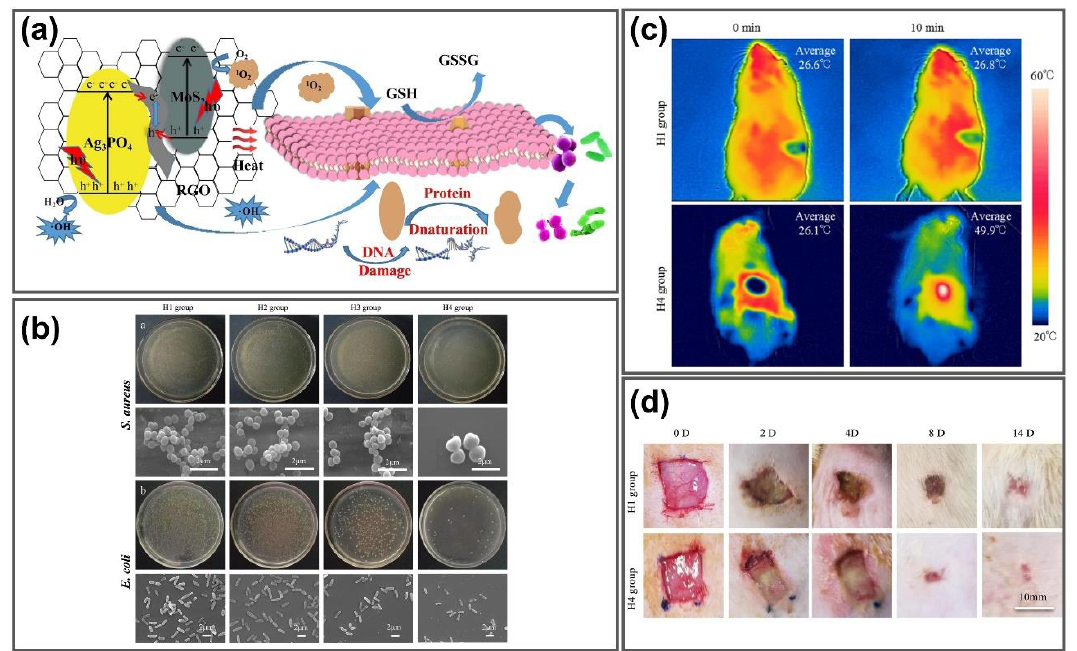
Figure 8. GGels for antibacterial and wound healing application. ( a ) ROS generation mechanism of rGO/MoS 2 /Ag 3 PO 4 composite hydrogels and inactivation mechanism for bacteria under light irradiation. ( b ) Representative colony-forming unit images and SEM images of S. aureus and E. coli of in vitro antibacterial assay of different hydrogels (H1 group: pure hydrogel; H2 group: GO hydrogel; H3 group: rGO/MoS 2 hydrogel; H4 group: rGO/MoS 2 /Ag 3 PO 4 hydrogel). ( c ) In vivo thermal imaging of hybrid hydrogels on the back of the rats under 0 min and 10 min exposure of dual lights. ( d ) In vivo wound healing effects of composite hydrogels in the rats after different treatment durations. Adapted with permission from [142] .